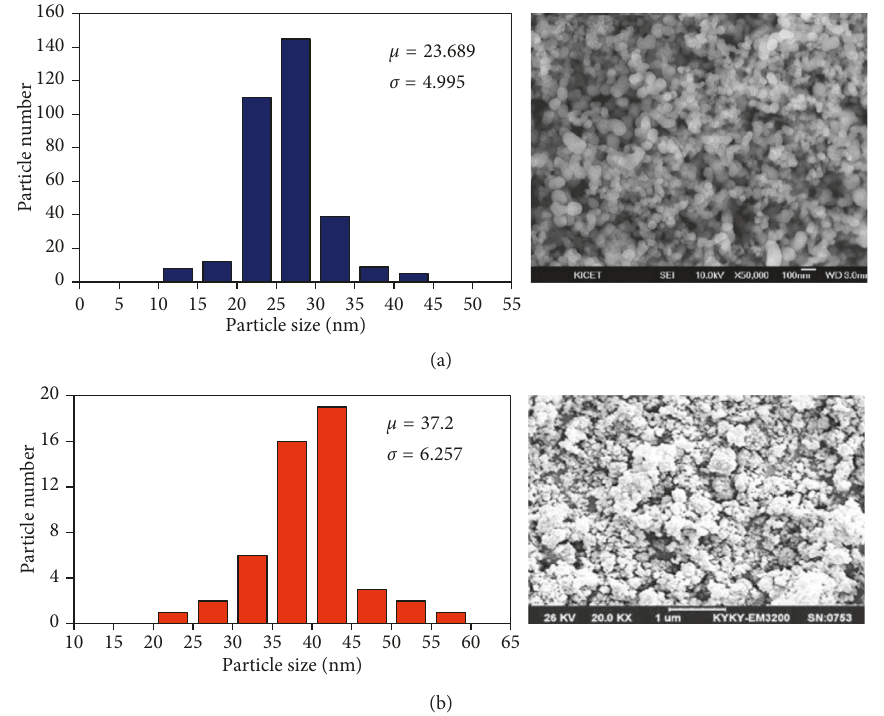
2 and (b) nano-ZnO.